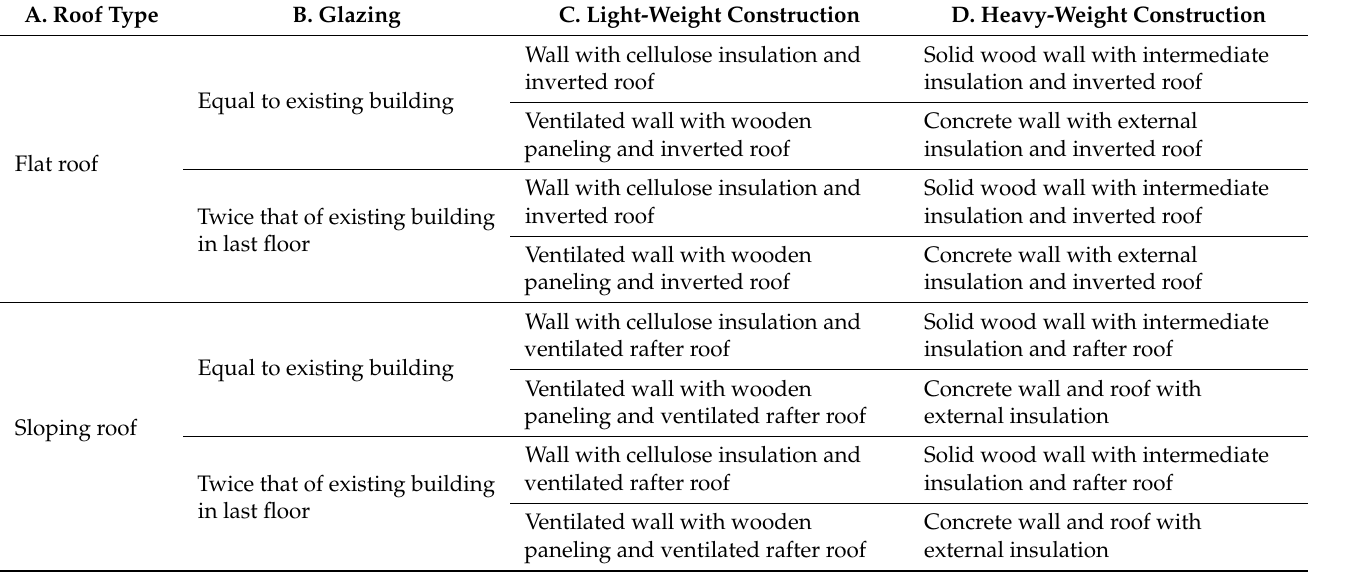
Table 1. Overview: buildings extensions with different construction types [53].